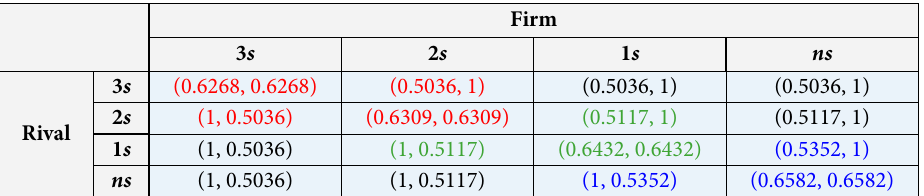
Table 6. Technological transition: four observations, risk-neutral DM, and signals on X 1